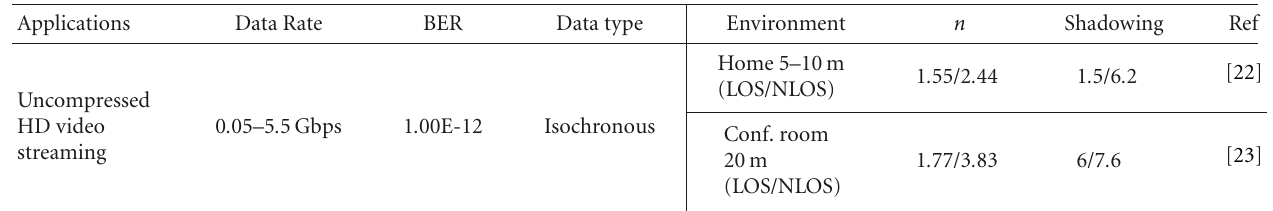
Table 3: Key requirements for uncompressed HD video streaming application and the large scale fading parameters for conference room and home environment, respectively.